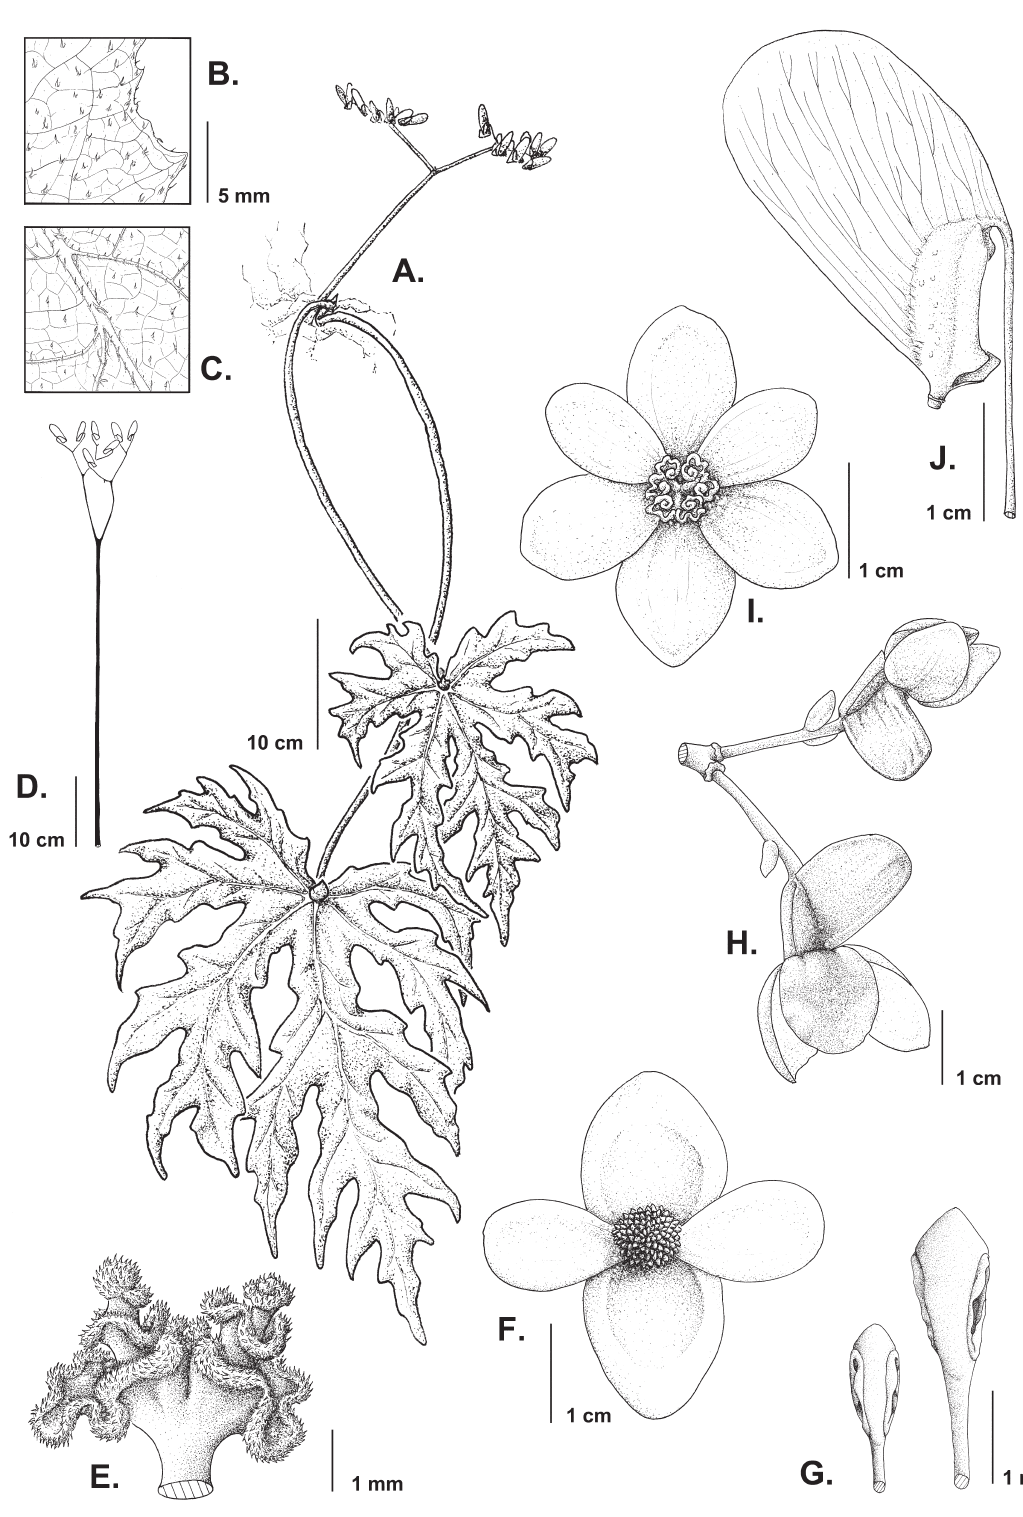
Fig. 35. Illustration of B. koelzii R.Camfield sp. nov. A . Plant habit. B . Adaxial leaf surface. C .